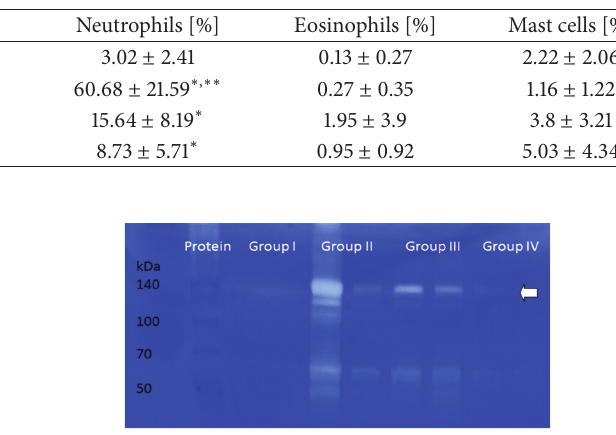
Figure 1: Gelatin zymography of MMP-2 and MMP-9. Examples of healthy controls (group I), RAO (group II), IAD (group III), and CIP (group IV). The 70kDa bands are representative of pro-MMP-2 and those at 140kDa are representative of high molecular weight MMP- 9 (arrow) as checked in a comparison of protein marker and human MMP-2 and MMP-9 (data not